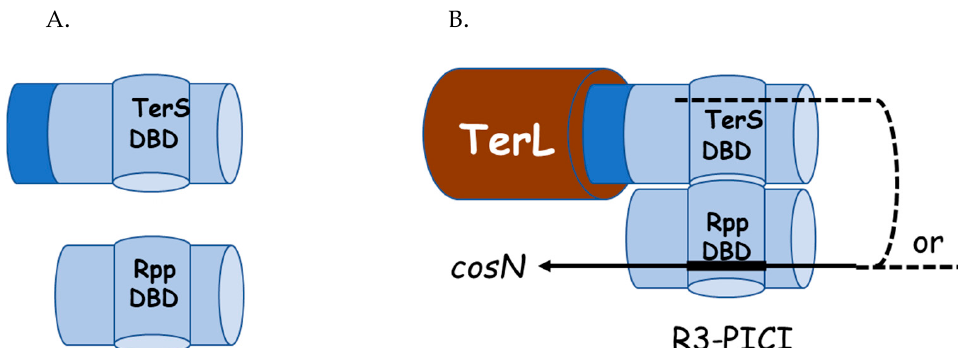
Figure 5. Proposed architecture of the Rpp-Ter sponsored initiation complex at cosB -PICI. ( A ). Domain structures for monomeric TerS and Rpp. The Rpp and TerS DBDs and oligomerization domains are small and large blue cylinders, resp. Dark blue represents the TerL-binding domain of TerS. ( B ). Proposed arrangement of the Rpp–TerS–TerL complex at cos -PICI. Components colored as in A with brown cylinder represent the N terminus of TerL.Solid line represents PICI DNA. Dashed lines indicate uncertainty about whether PICI DNA contacts the DBD of TerS. The proposed architecture of TerL at cosN is shown in Figure 1B.